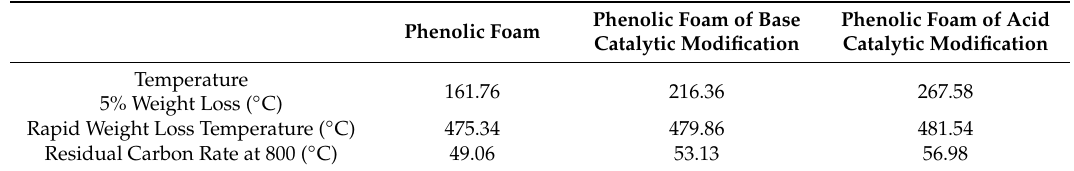
Table 3. Thermogravimetric data analysis of phenolic resin and modified neophenol resin.